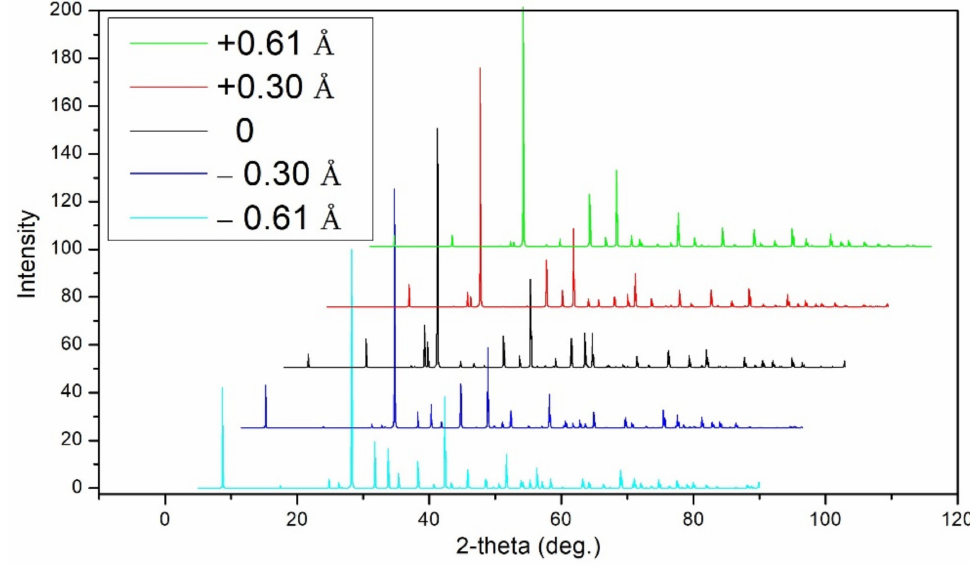
Figure 7. X-ray diffraction spectra of Sb 2 Te 3 generated for the ideal and distorted structures. From the system energy point of view, the distortion energy varies with the distortion distance along the <001> direction as shown in Figure 8. Bond elongation along the <001> direction of the tetrahedron results in the compression of the first NN Sb-Te bonds which features strong force constants, while the tension of the second NN Sb-Te bonds features weak force constants. From Figure 8 it is noted that when the magnitude of distortion is smaller than 0.17 Å, the distortion energy of stretching process is higher than that of compressing process, suggesting that the strong bonds are more difficult to be compressed and the weak bonds are easier to be stretched, consistent with the FCs results. When the magnitude of distortion is larger than 0.17 Å, the bond initially featuring strong FCs will become longer than the bond initially featuring weak FCs, leading to the exchange of the relative strong and weak characteristics of FCs, namely, the initial stronger bonds become weaker and the initial weaker bonds become